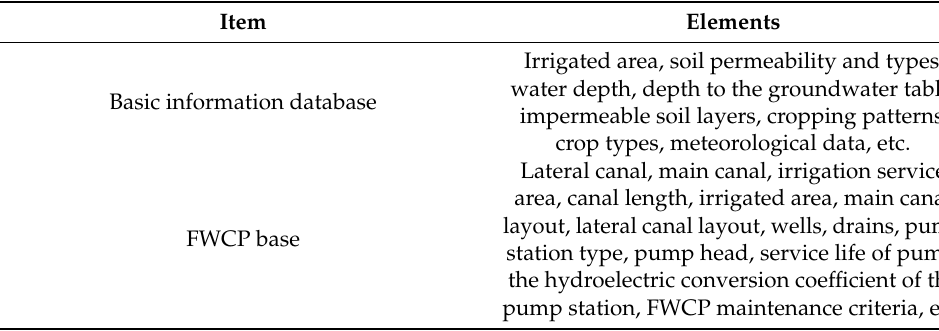
Table 1. Elements referred to two databases in the